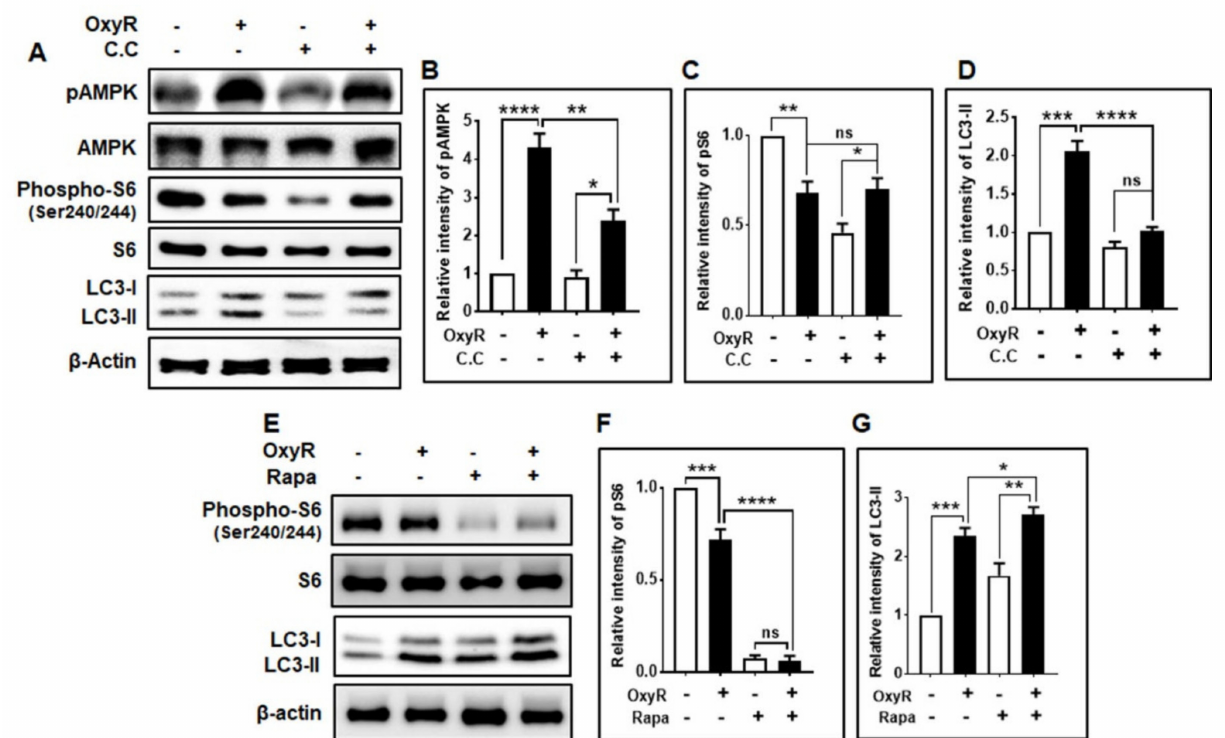
Figure 3. OxyR-activated autophagy via the AMPK)-mTOR pathway in cortical astrocytes. ( A ) Astrocytes were pretreated with compound C (10 µ M) for 1 h in the presence or absence of 10 µ M OxyR for a further 24 h. pAMPK, AMPK, phospho- S6 ribosomal protein (Ser240/244), S6 ribosomal protein, and LC3 expression levels were determined by performing immunoblotting. ( B – D ) Densitometry analyses of the represented proteins were performed using ImageJ, and individual expression levels were normalized to those of β -actin. Statistical analysis was accomplished by one-way ANOVA. ( E ) Cells were pretreated with rapamycin for 30 min before OxyR (10 µ M) treatment for 24 h. Phospho-S6, S6, and LC3 levels were measured by performing immunoblotting. ( F , G ) All data were derived from one-way ANOVA. Data are presented as mean ± SEM. * p < 0.05, ** p < 0.01, *** p < 0.001, **** p < 0.0001, ns: non-significant. OxyR, oxyresveratrol; C.C, compound C (AMPK inhibitor); AMPK, AMP-activated protein kinase; pAMPK, phosphorylated AMPK; LC3, microtubule-associated protein light chain 3; Rapa, rapamycin; S6, S6 ribosomal protein; pS6, phosphorylated